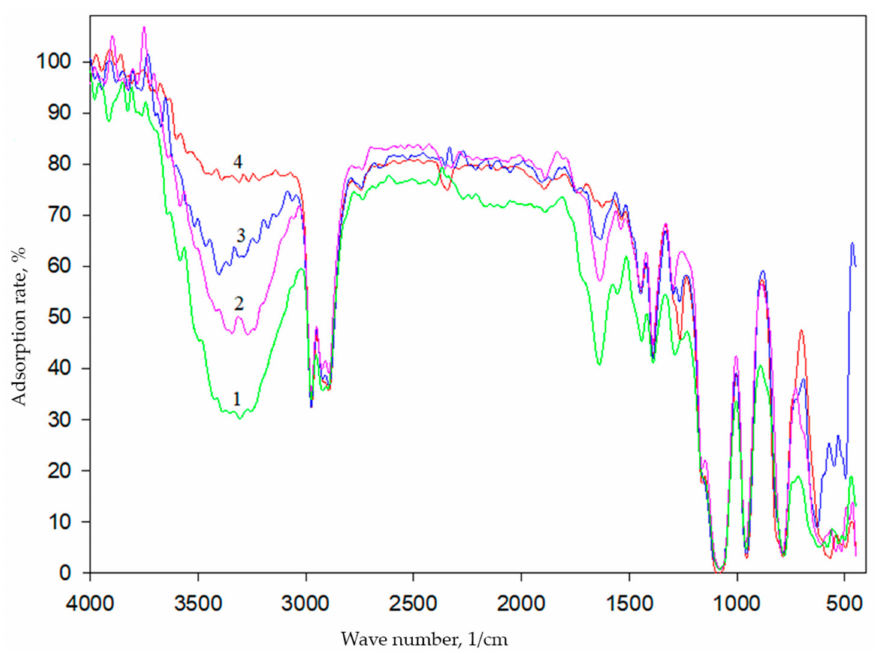
Figure 1. IR spectra of an organosilicon matrix obtained within an hour (1—100% TEOS, 2—85% TEOS, 3—50% TEOS, 4—15% TEOS).